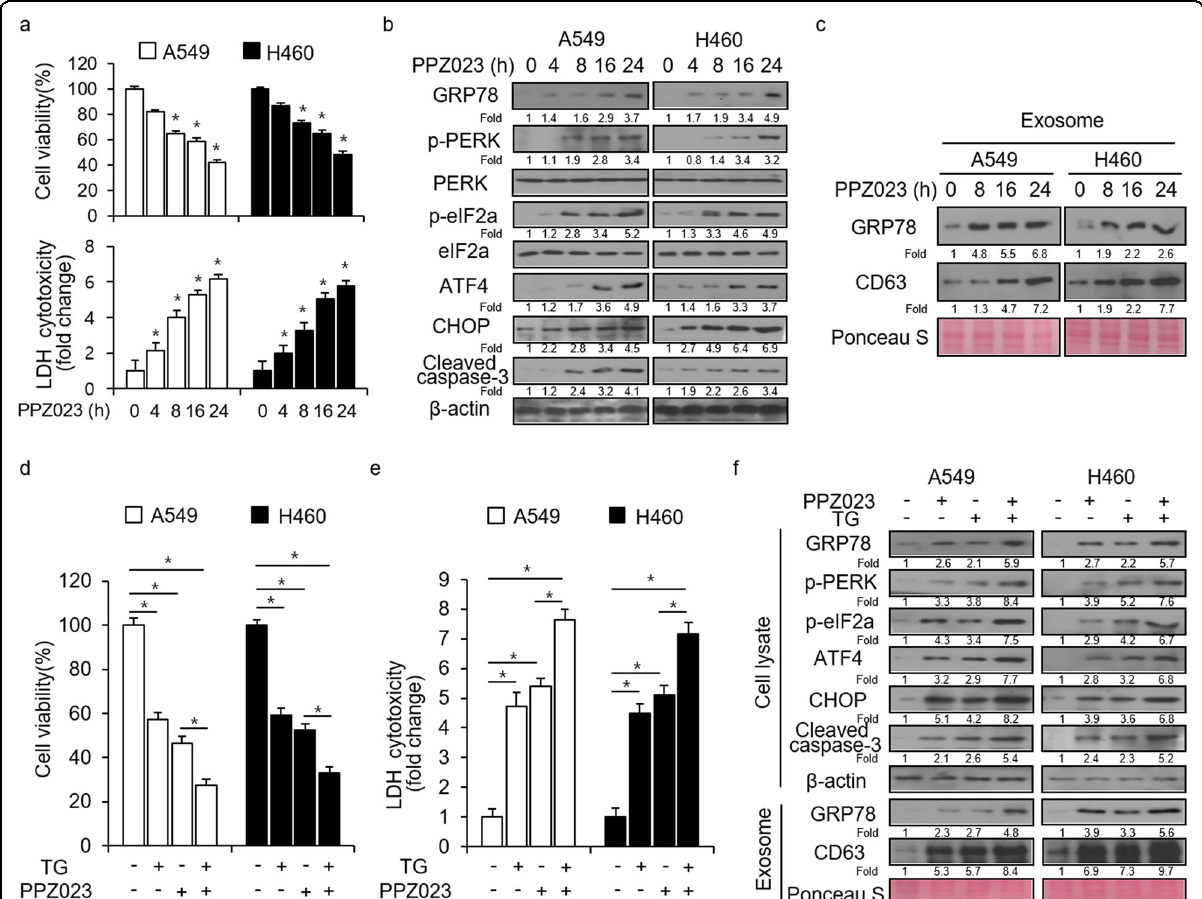
Fig. 3 PPZ023 mediates ER stress and cell death through PERK signaling in NSCLC cells. a A549 and H460 cells were treated for various time periods (0, 4, 8, 16, and 24 h) with PPZ023 (25 μ M), and WST-1 and LDH assays were performed under these conditions; * p < 0.05. b , c Protein samples isolated from cell lysates and exosomes were subjected to western blot analyses of GRP78, p-PERK, PERK, p-eIF2 α , eIF2 α , ATF4, CHOP, cleaved caspase-3, and CD63. β -Actin and Ponceau S stain were used as protein loading controls. d , e A549 and H460 cells were treated with TG (3 μΜ , 24 h) and PPZ023 (25 μΜ , 24 h). Cell viability and LDH release were determined using WST-1 and LDH assays, respectively; * p < 0.05. f Western blot analysis was performed to assess the protein expression of GRP78, p-PERK, p-eIF2 α , ATF4, CHOP and cleaved caspase-3 and exosome expression of GRP78 and CD63. β -Actin was used as the protein loading control and Ponceau S stain was used as the exosome loading